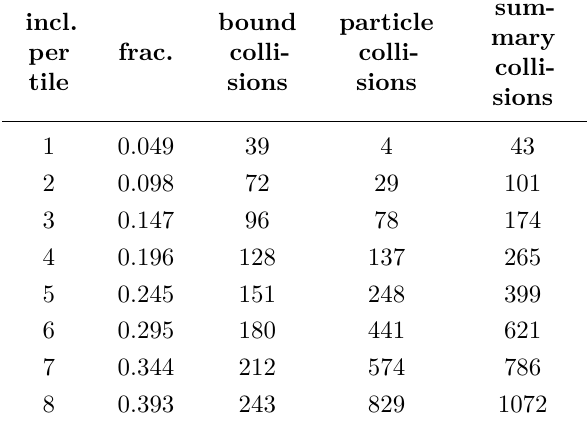
Table 2. Computer demands – number of collisions.